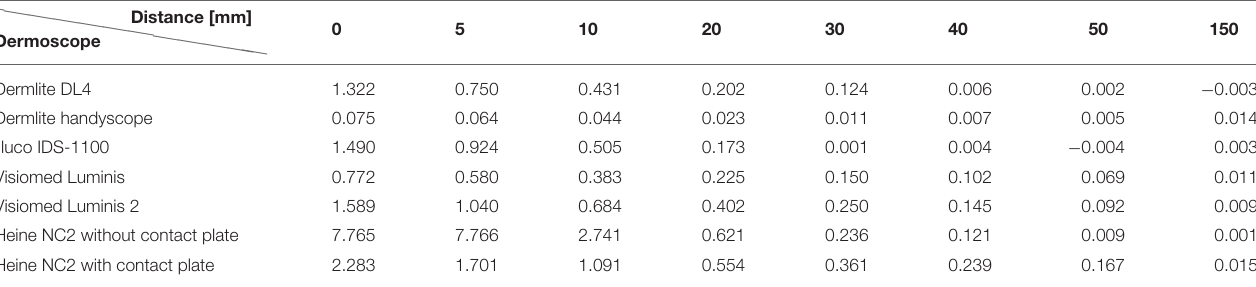
TABLE 1 | The strength of the magnetic field depending on the type of dermoscope and distance from the faceplate. hhhhhhhhhhhh Distance Dermoscope